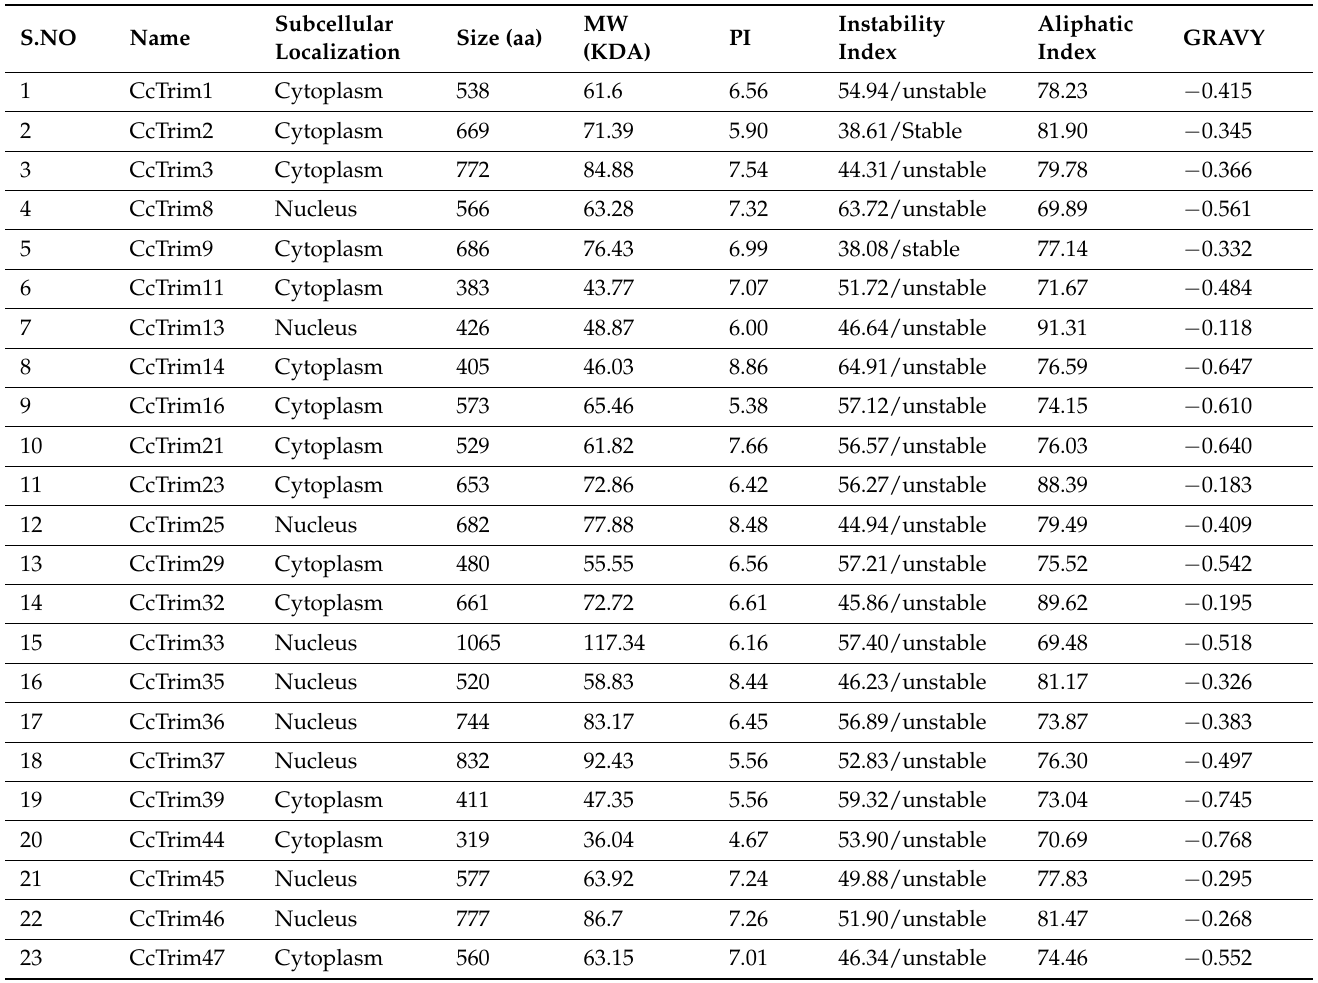
Table 2. Physico-chemical properties and subcellular localization of TRIM proteins in common carp. Detailed information on size of amino acids (aa), molecular weight in kilodalton (MW kDa), iso-electric point (PI), instability index, aliphatic index, and grand average of hydropathicity (GRAVY) predicted values are